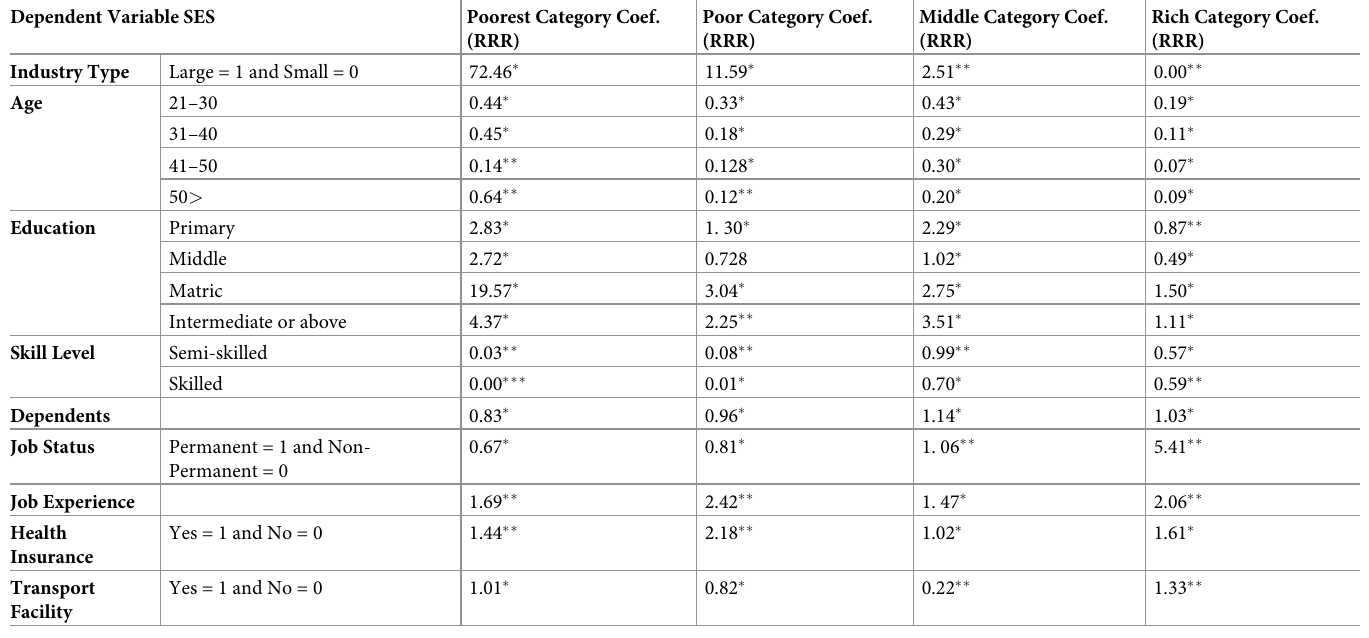
Table 4. Relative risk